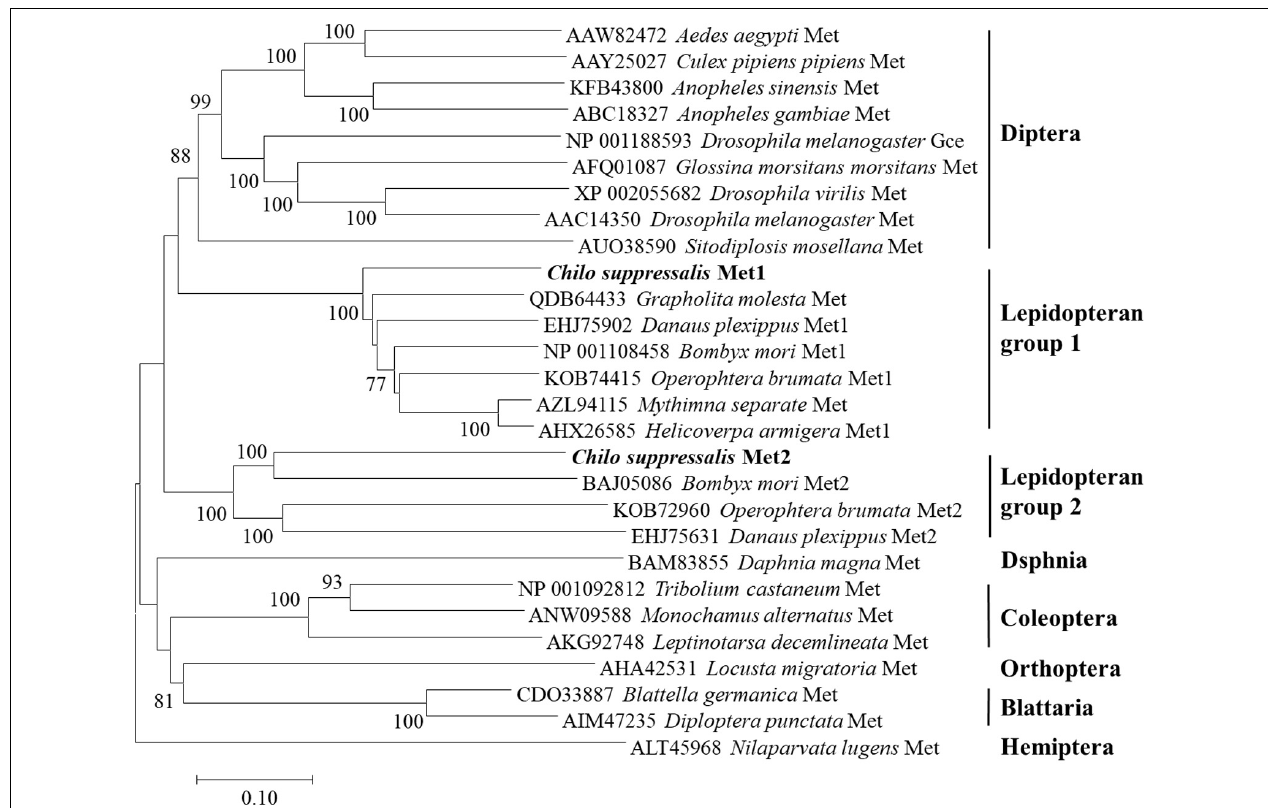
FIGURE 2 | Phylogenetic relationships of CsMet1 , CsMet2 and other insect Mets. The neighbor-joining tree was constructed by MEGA 7.0. Numbers indicated bootstrap support values (%) based on 1,000 replicates. Sequences were retrieved from GenBank protein database.